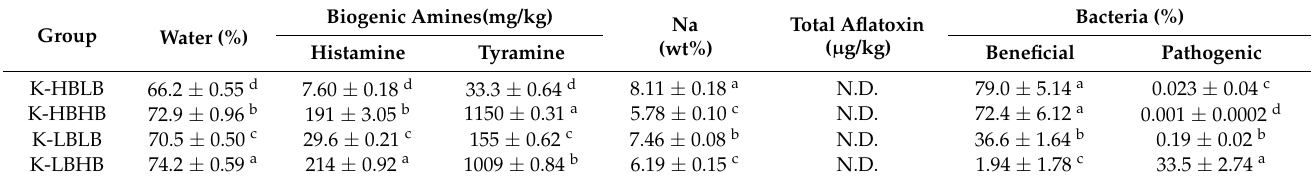
Table 1. General characteristics of different types of traditionally made kanjang (TMK).